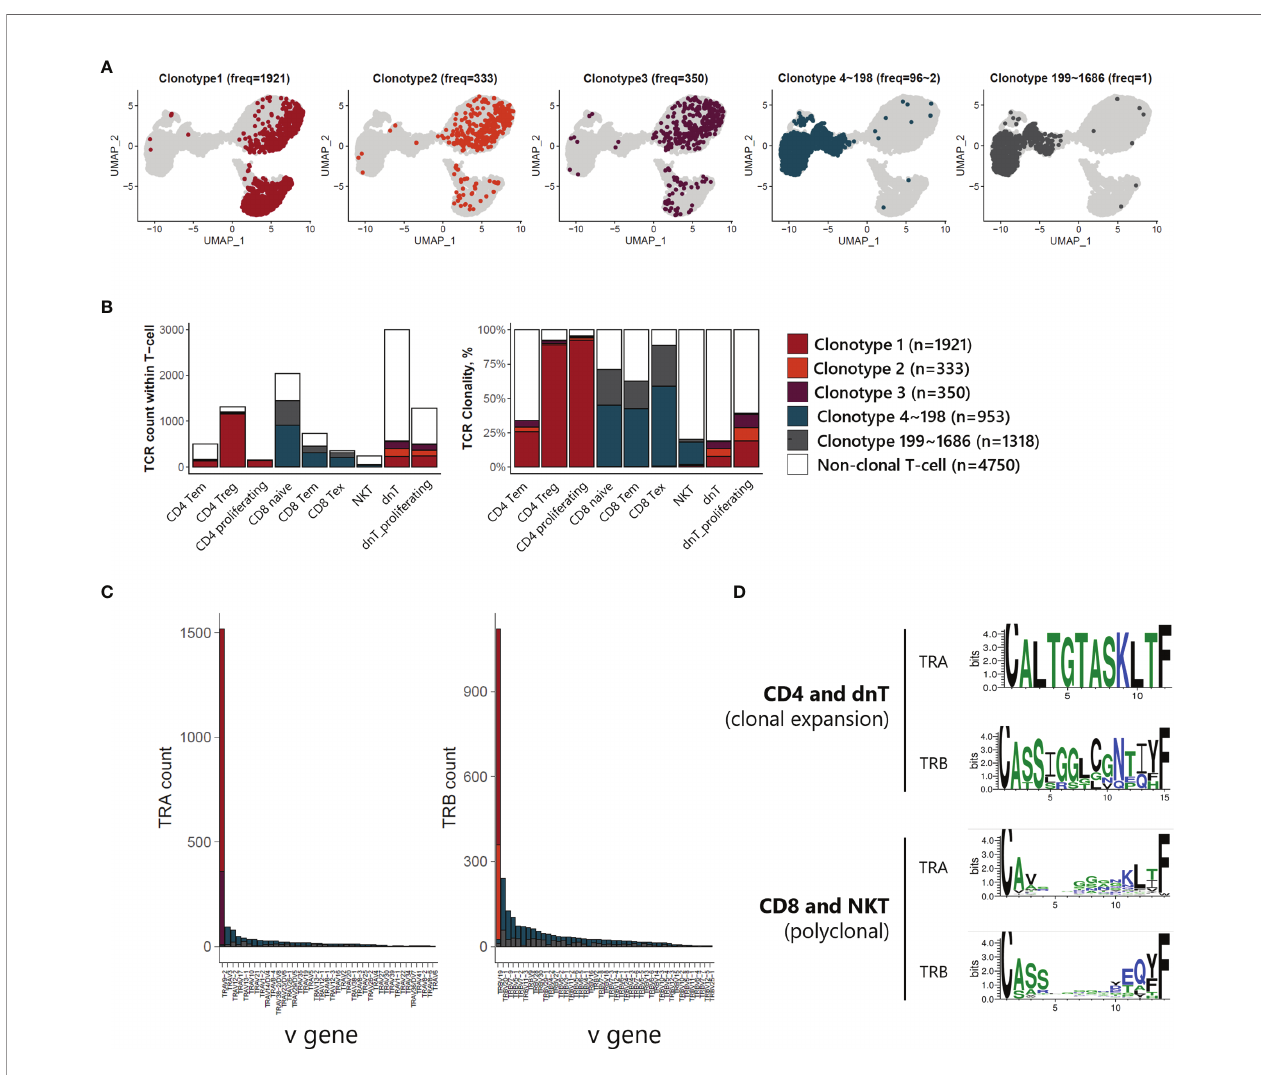
FIGURE 4 | TCR analysis of T-cells of ATLL (A) TCR clonotype expansion within T-cells (B) Proportional expansion of each TCR clonotype within the different T-cell subtypes (C) Composition of variable gene of TRA and TRB (D) Weblogo plot showing conserved amino acid sequence of TRA and TRB according to T-cell